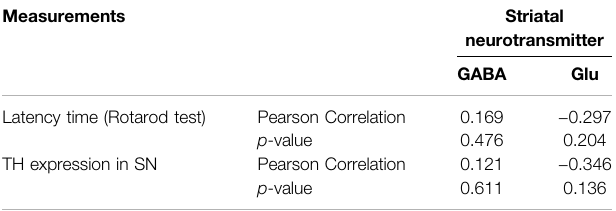
GABA, γ -aminobutyric acid; Glu, glutamate; TH, tyrosine hydroxylase; SN, substantia